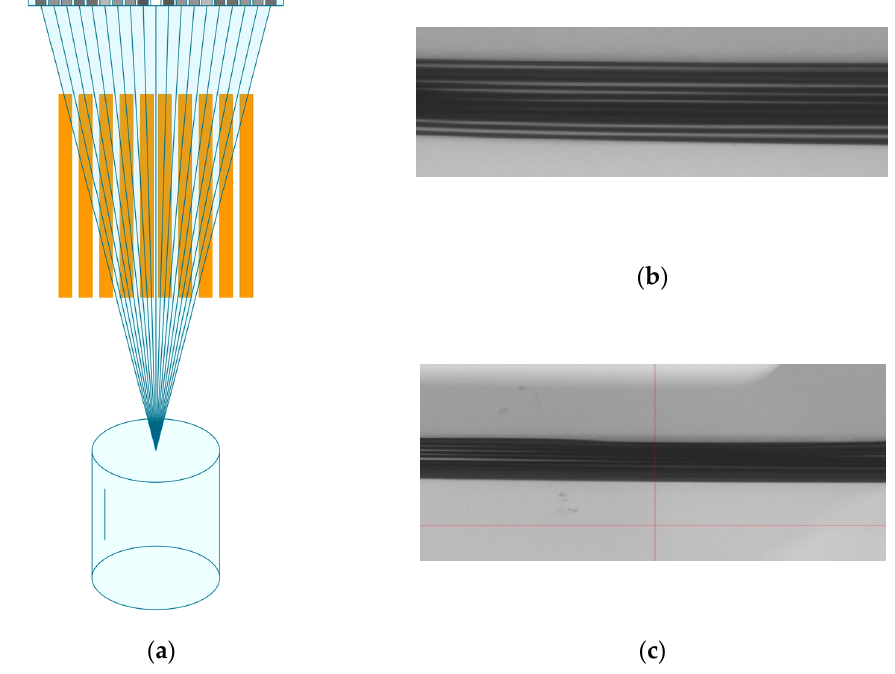
Figure 2. X-rays of HTS coils. ( a ) Scheme of the image; ( b , c ) examples of